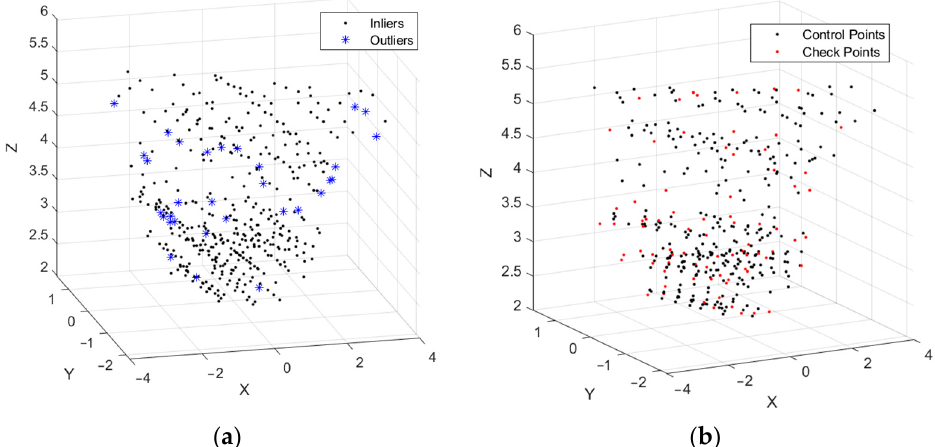
Figure 4. 3D points in RGB-D camera. ( a ) Inliers and outliers calculated by BaySAC; and ( b ) distribution of control points and check points.